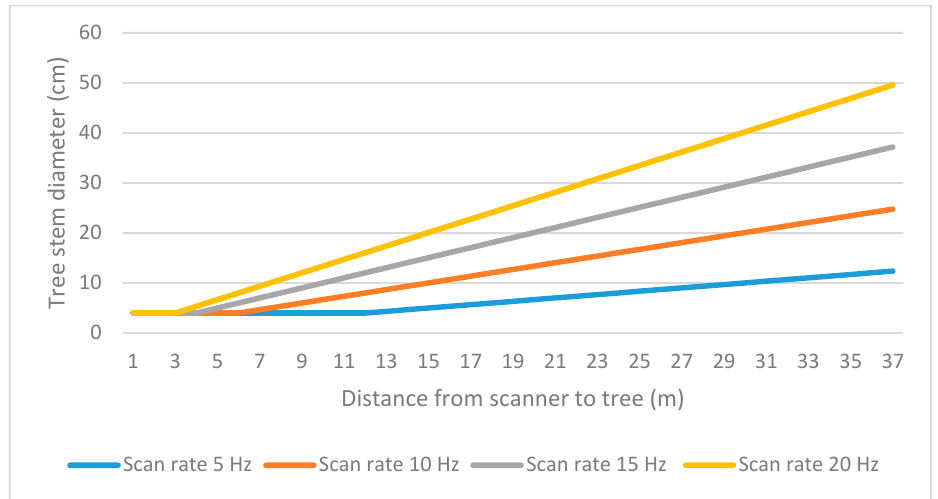
Figure 7. Minimum diameter at breast height as a function of observation distance and scan rate calculated from Equation (1). Each diameter estimation requires minimum three laser points hitting the tree stem. Then minimum detectable diameter is set to 4 cm.